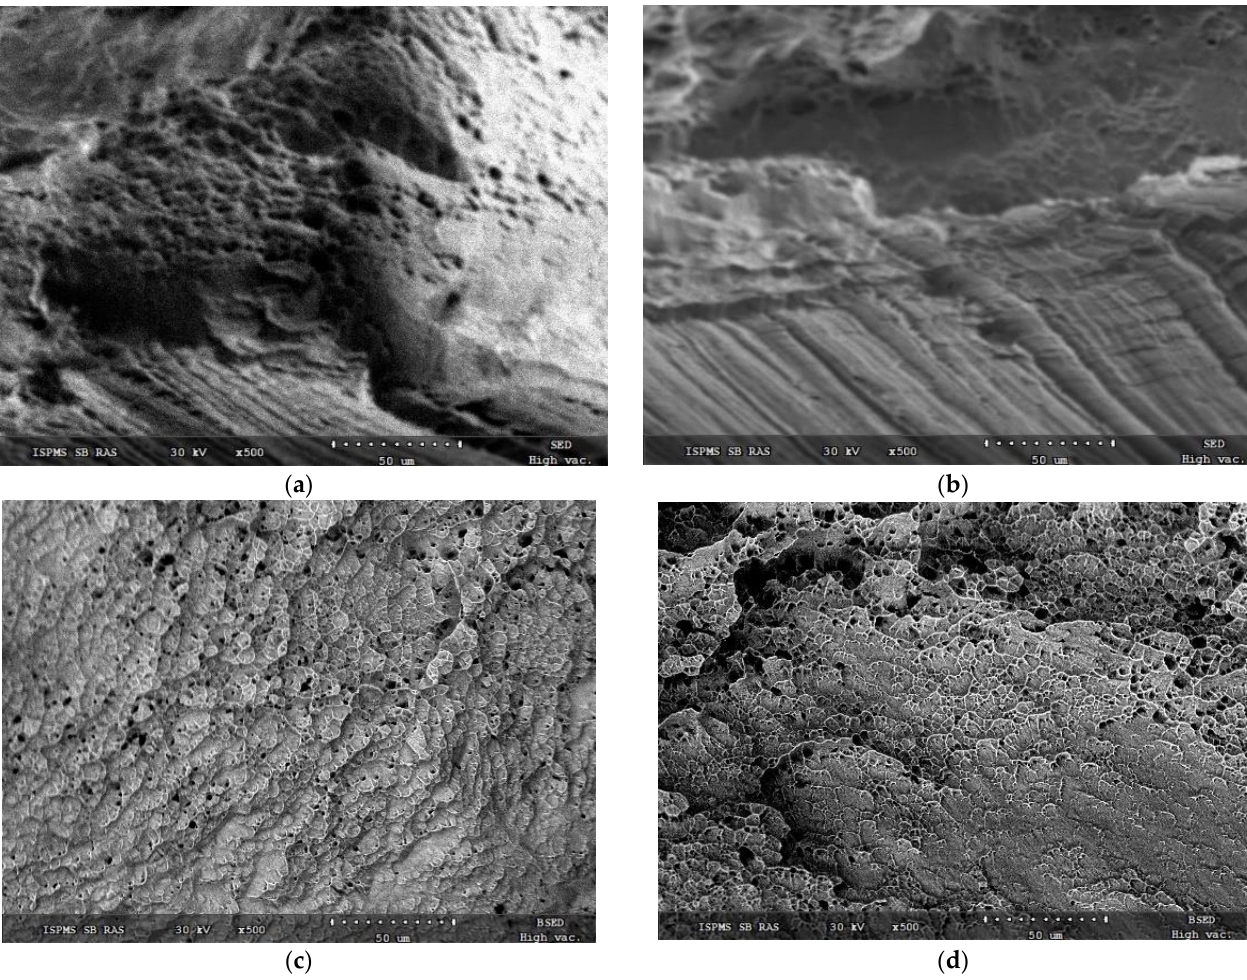
Figure 15. Fracture surface after tension test for samples 4 printed at 0.21 kJ/mm ( a , b ), 0.255 kJ/mm ( c ) and 0.3 kJ/mm ( d ) heat input.